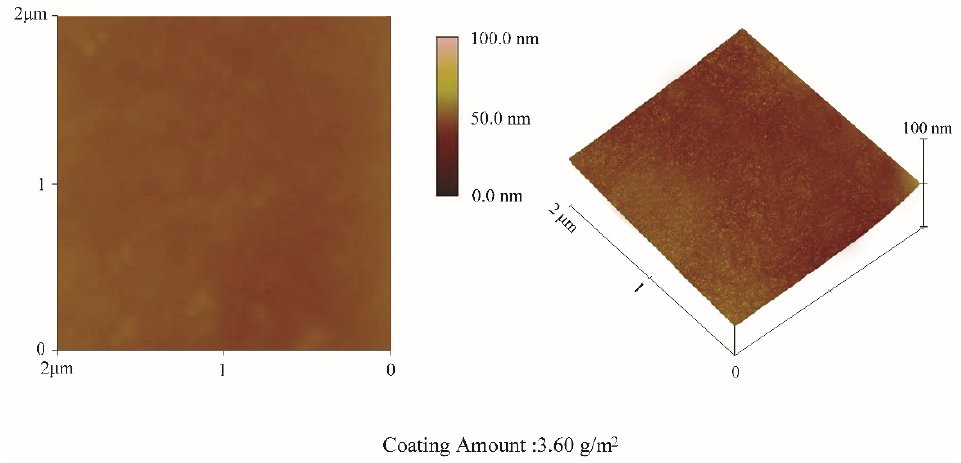
Figure 16. AFM views of the coated packaging paper (coating amount: 2.55 g/m 2 ).